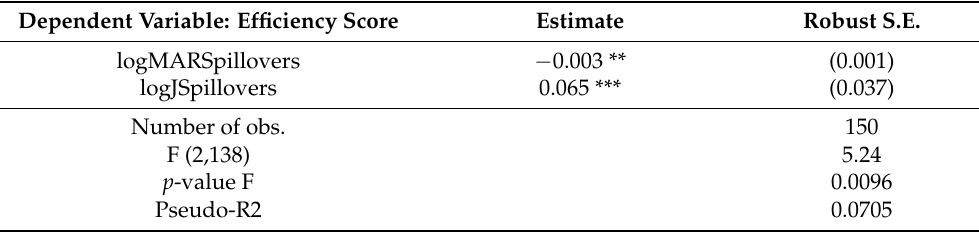
Table 6. Fixed Effect regression: all countries 2002–2017. Dependent Variable: Efficiency Score Estimate Robust S.E.